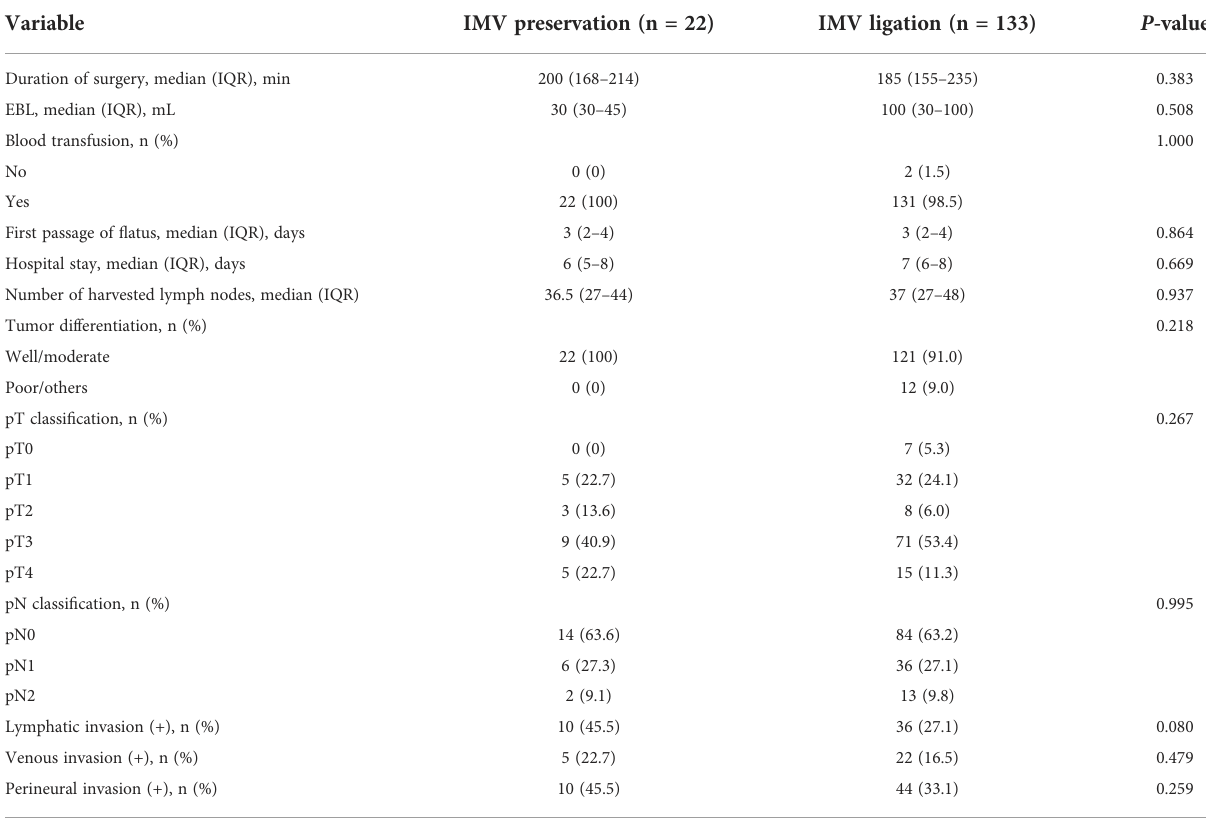
TABLE 2 Peri- and post-operative outcomes and pathologic features.